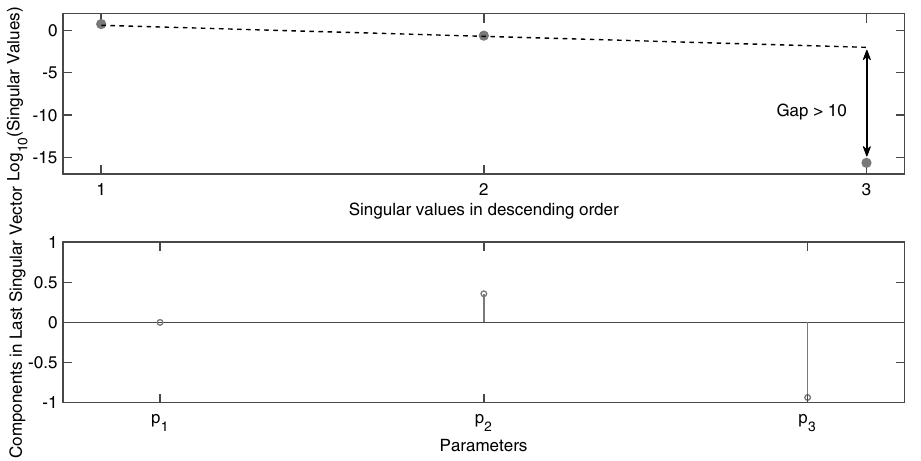
Figure 1. Identifiability signature of Example 1: small benchmark model ( M 1 ). (Top) Singular values: For x 2 ( 0 ) = 0 and y = x 1 , the rank deficiency of the sensitivity matrix is indicated by a distinct gap between the second and third singular values. This suggests that this model is structurally unidentifiable and that there is a single set of totally correlated parameters. (Bottom) Elements of the singular vector related to the zero valued singular value. The nonzero components indicate that parameters p 2 and p 3 are structurally